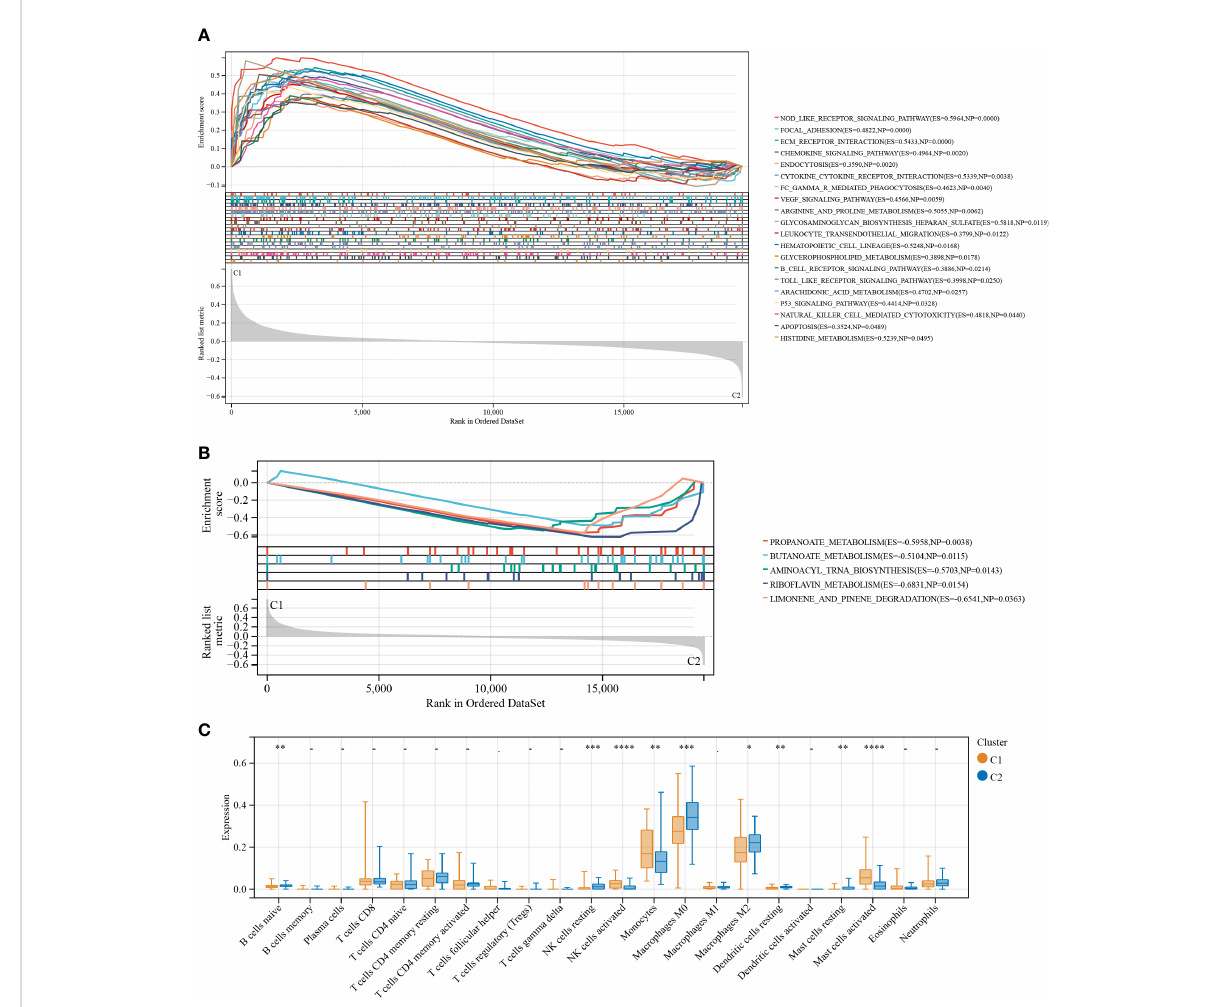
FIGURE 4 Enrichment analysis and the immune in fi ltration characteristics of the two identi fi ed subgroups with distinct prognoses. (A) GSEA for cluster 1 (C1) and cluster 2 (C2). Immune and metabolism-related pathways were signi fi cantly enriched by cluster 1. (B) and another fi ve metabolism- related pathways were signi fi cantly enriched by cluster 2. (C) Boxplots shows differences in the in fi ltrating immune cells between clusters 1 and 2. *p < 0.05; **p < 0.01; ***p < 0.001; and ****p <